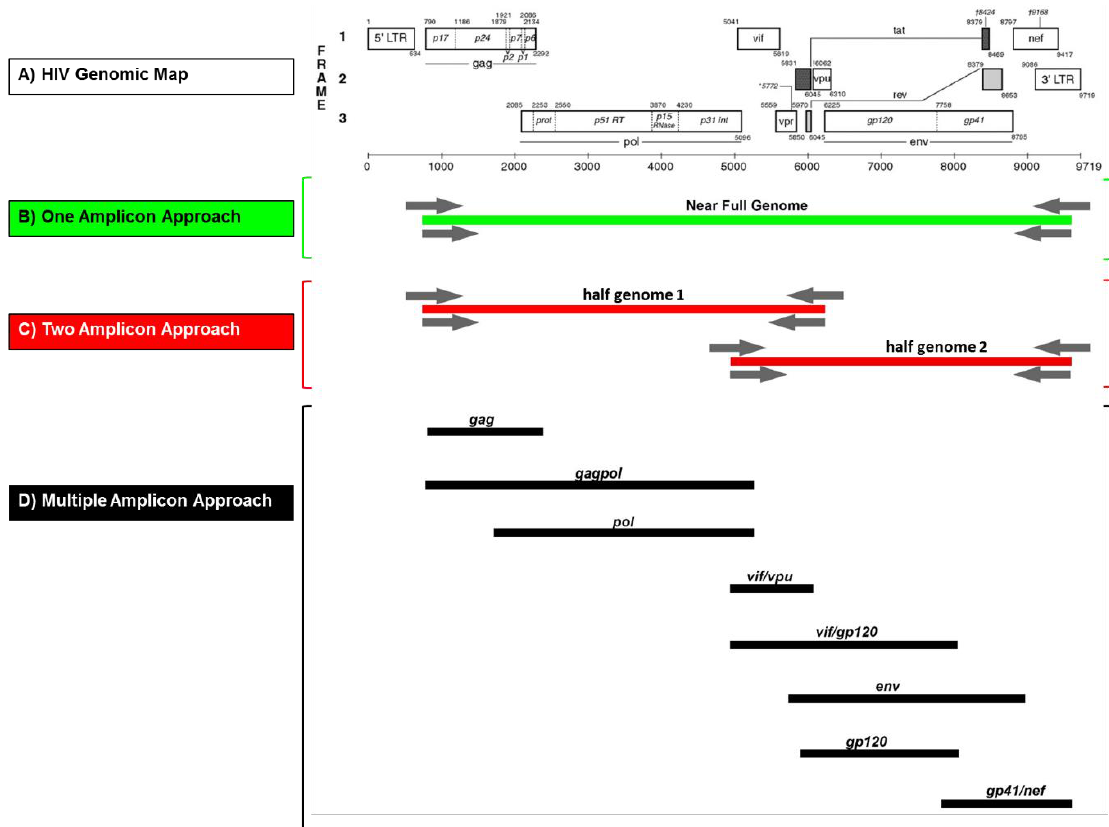
Figure 1. Near full genome sequence amplification approaches. ( A ) Genome map of HIV-1 reference strainHxB2(GenBank: K03455). ( B )One-ampliconapproachtoobtainasingle9.1kbPCRfragment(near full genome) shown in green. ( C ) Two-amplicon approach with two overlapping PCR fragments (shown in red), with half genome 1 (HG1) 5.2 kb and half genome 2 (HG2) 4.6 kb in size. ( D ) Multiple-amplicon approach: Selection of eight overlapping PCR fragments (shown in black), i.e. gag (1.5 kb), gagpol (4.5 kb), pol (3.2 kb), vifvpu (1.5 kb), vif / gp120 (3 kb), env (3.4 kb), gp120 (1.7 kb) and gp41 / nef (1.8 kb). Positions of primers are schematically shown with gray arrows in (A) and